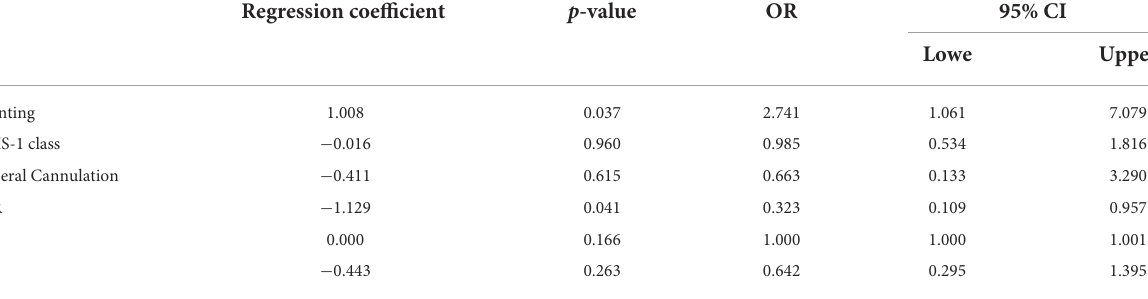
TABLE 5 Logistic regression model predicting in-hospital